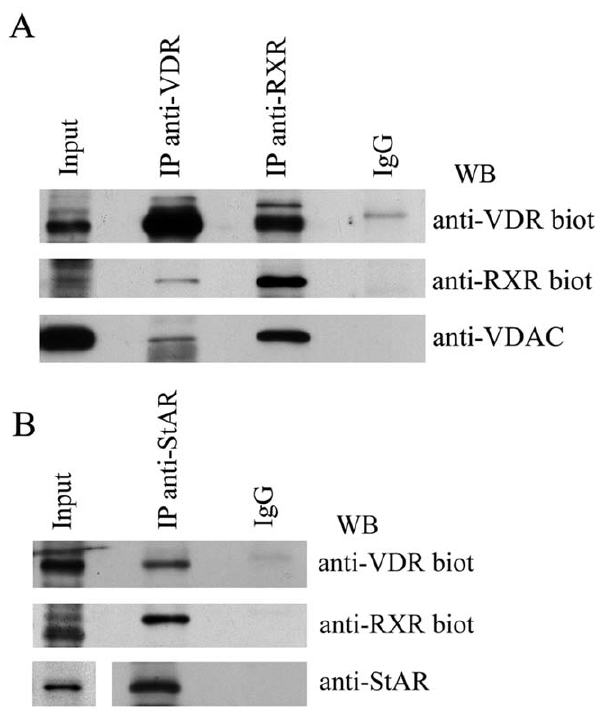
Figure 2. VDR association with RXR a and PTP proteins. (A) Mitochondrial extracts from untreated HaCaT cells were immunopre- cipitated with anti-VDR and anti-RXR a rabbit antibody and detection by western blotting was performed with anti-VDR or anti-RXR a biotiny- lated antibodies and with anti-VDAC rabbit antibody. (B) The interaction between VDR, RXR a and StAR was investigated in mitochondrial fraction by immunoprecipitation with anti-StAR rabbit antibody followed by western blotting and detection with anti-VDR and anti- RXR a biotinylated antibodies. In every assay a 10% input was used as a positive control and immunoprecipitation with normal IgG as negative control.